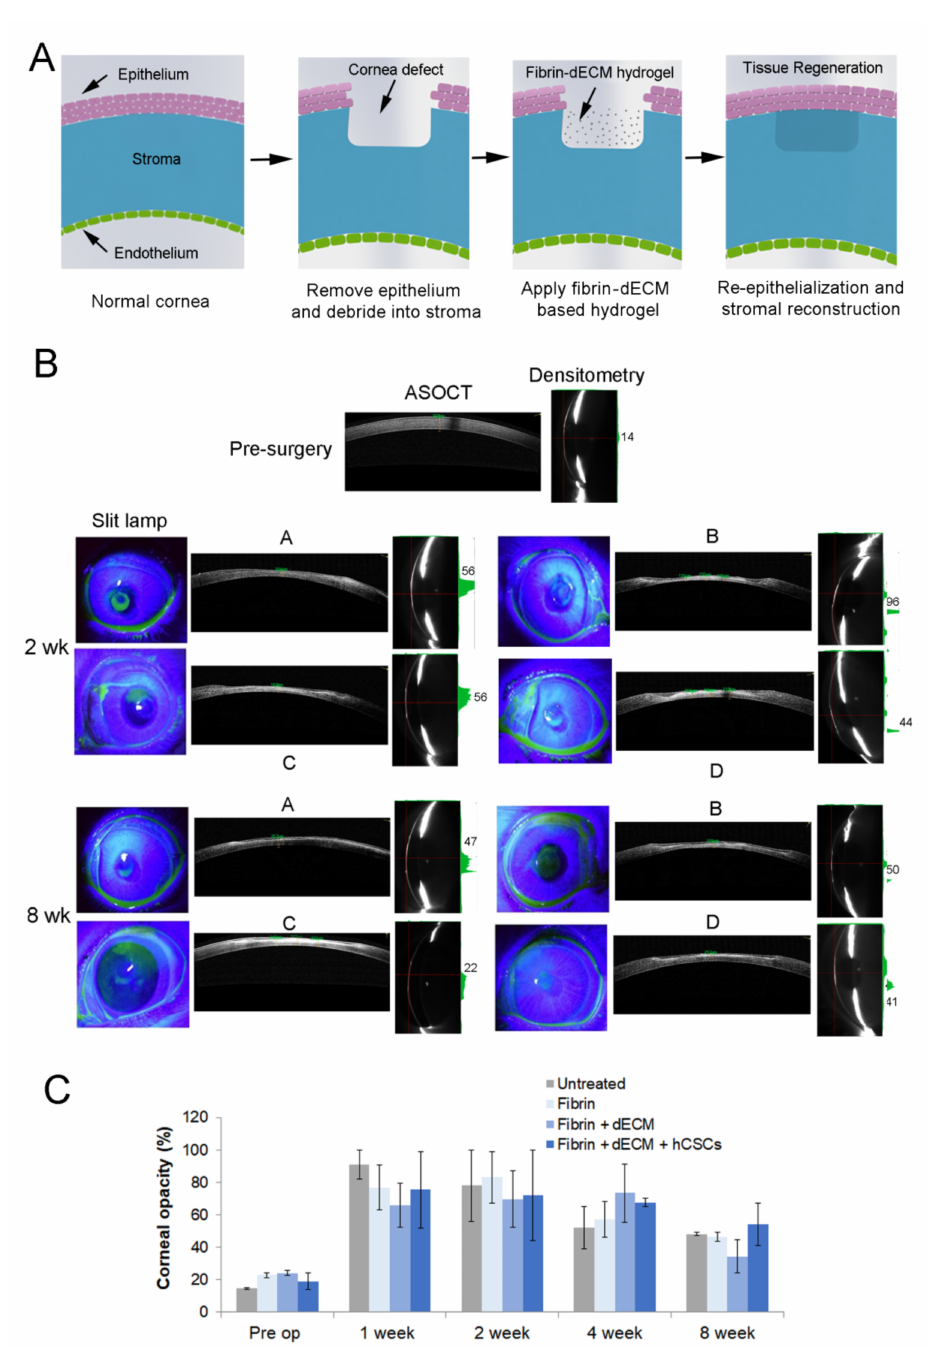
Figure 4. Rabbit cornea imaging in vivo. ( A ) Schematic depicting the creation of corneal defect and application of fibrin–dECM based hydrogels for ocular tissue reconstruction. ( B ) Representative images of rabbit corneas obtained using slit lamp with fluorescein staining, ASOCT and densitometry two and eight weeks post-application of fibrin based hydrogels. Corneas are represented as: (A) untreated; (B) fibrin controls; (C) fibrin + dECM microparticles; and (D) fibrin + dECM + hCSCs. Prior to surgery, corneas of all animals exhibited nominal corneal thickness with good optical clarity. ( C ) Bar graph depicts the decrease in corneal haze, an indicator of corneal wound healing, determined via densitometric evaluations during the eight-week time